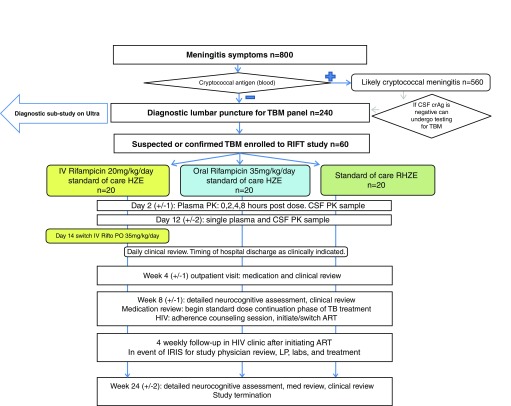
Study flow chart.